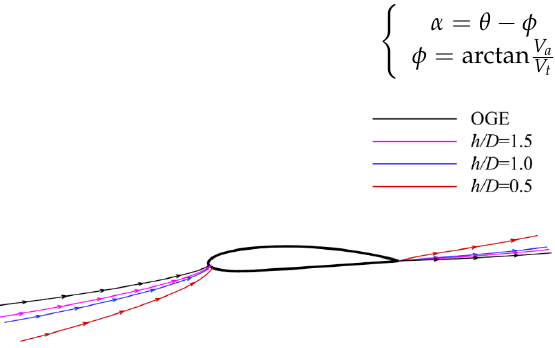
Figure 14. Stagnation streamlines of blade section at three-quarter radius.